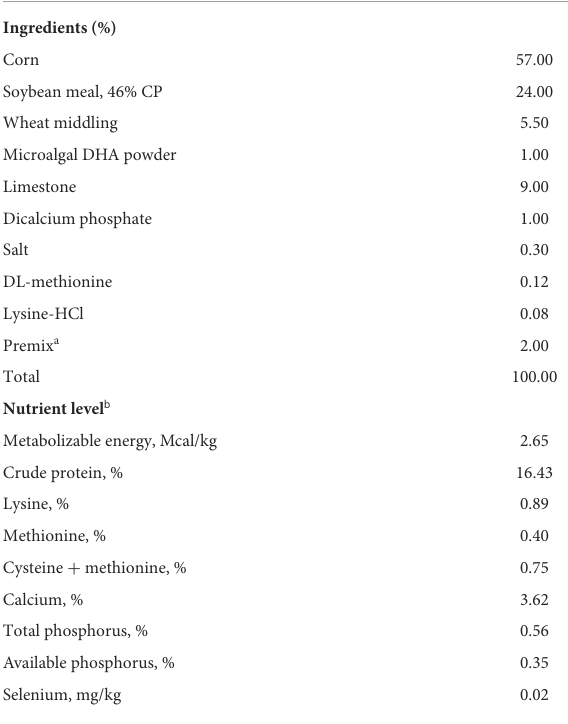
TABLE 1 Ingredients and nutrient contents of the basal diet (As-fed